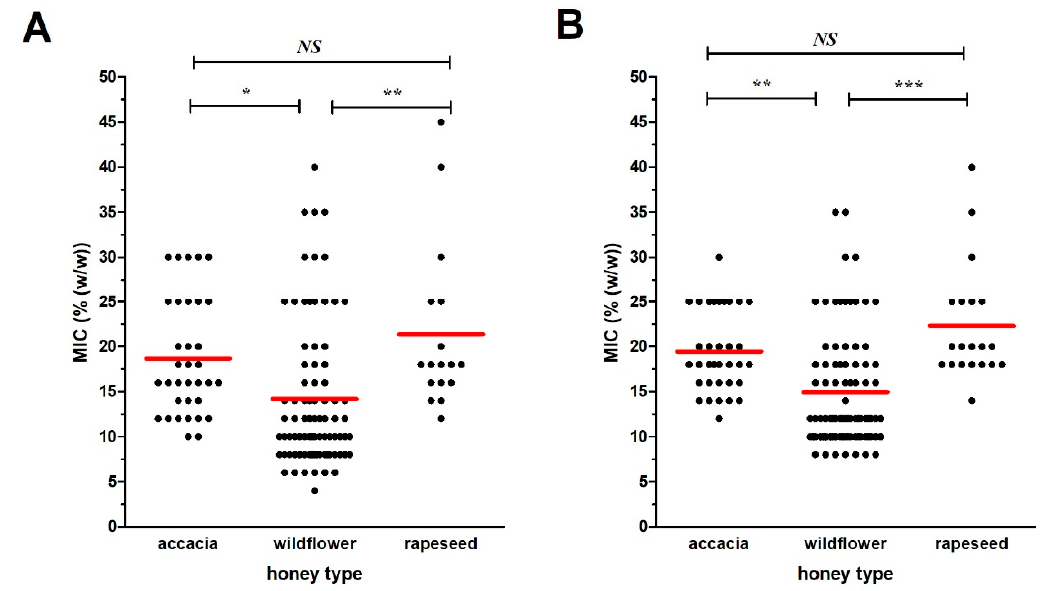
Figure 3. Comparison of overall antibacterial efficacy of different honey types. Antibacterial activity of acacia ( n = 15), wildflower ( n = 32), and rapeseed ( n = 8) honeys was determined against ( A ) Staphylococcus aureus and ( B ) Pseudomonas aeruginosa . Activity was determined with a minimum inhibitory concentration (MIC). Red line represents the mean of all measured data. Differences among groups of samples belonging to different honey types were analyzed by ANOVA. Asterisks indicate a significant difference between the examined honey types, * P < 0.05, ** P < 0.01, *** P < 0.001, NS- non-significant.